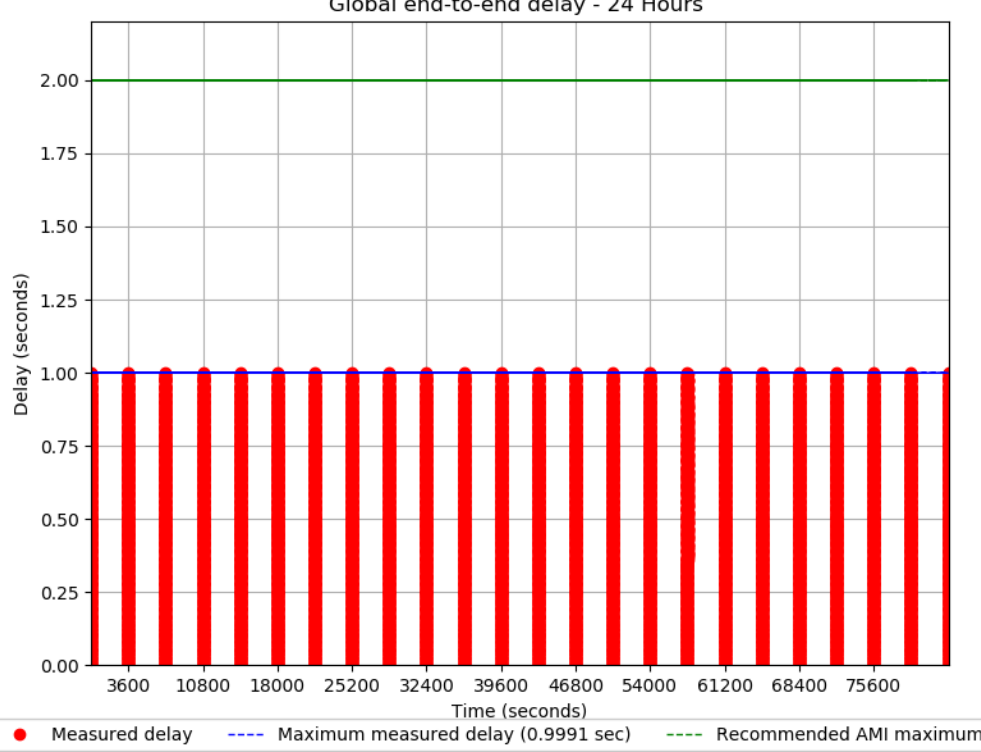
Figure 5. The global end-to-end delay during the daily cycle.